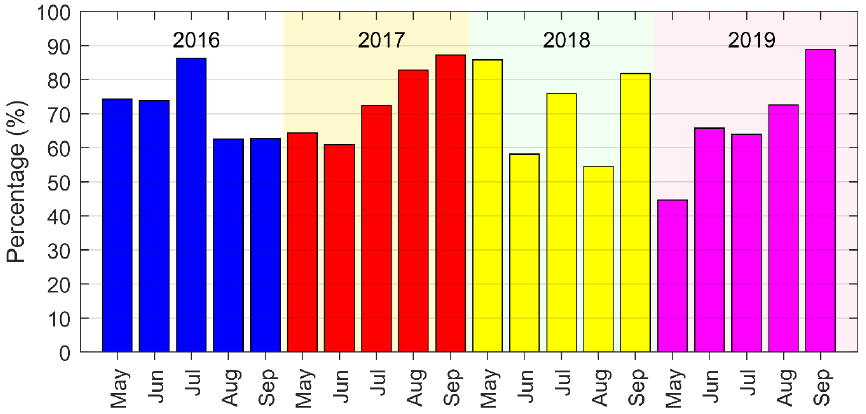
Figure 2. The percentage of the month a pixel is free from cloud influence, spatially averaged across the entire study region. The percentage was calculated from the daily images of the correspond- ing